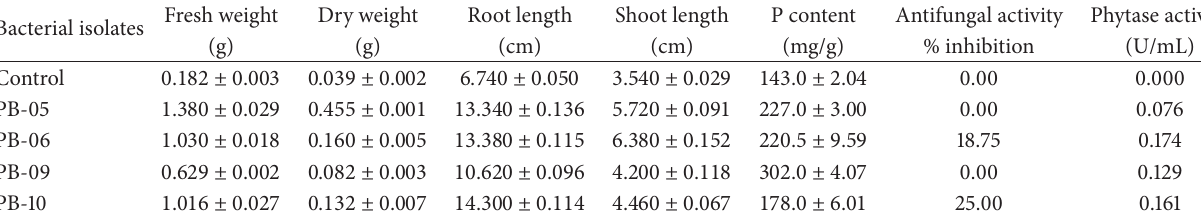
Table 2: Effect of seed bacterization on different plant growth parameters after 30 days of germination under greenhouse study. Fresh weight Bacterial isolates